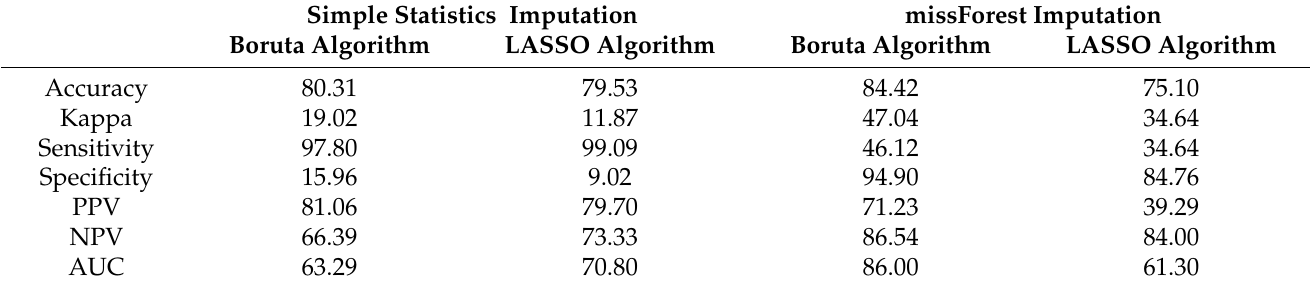
Table 3. Comparative permutations of the methods of missing values imputation and variable selection applied on the base ML model